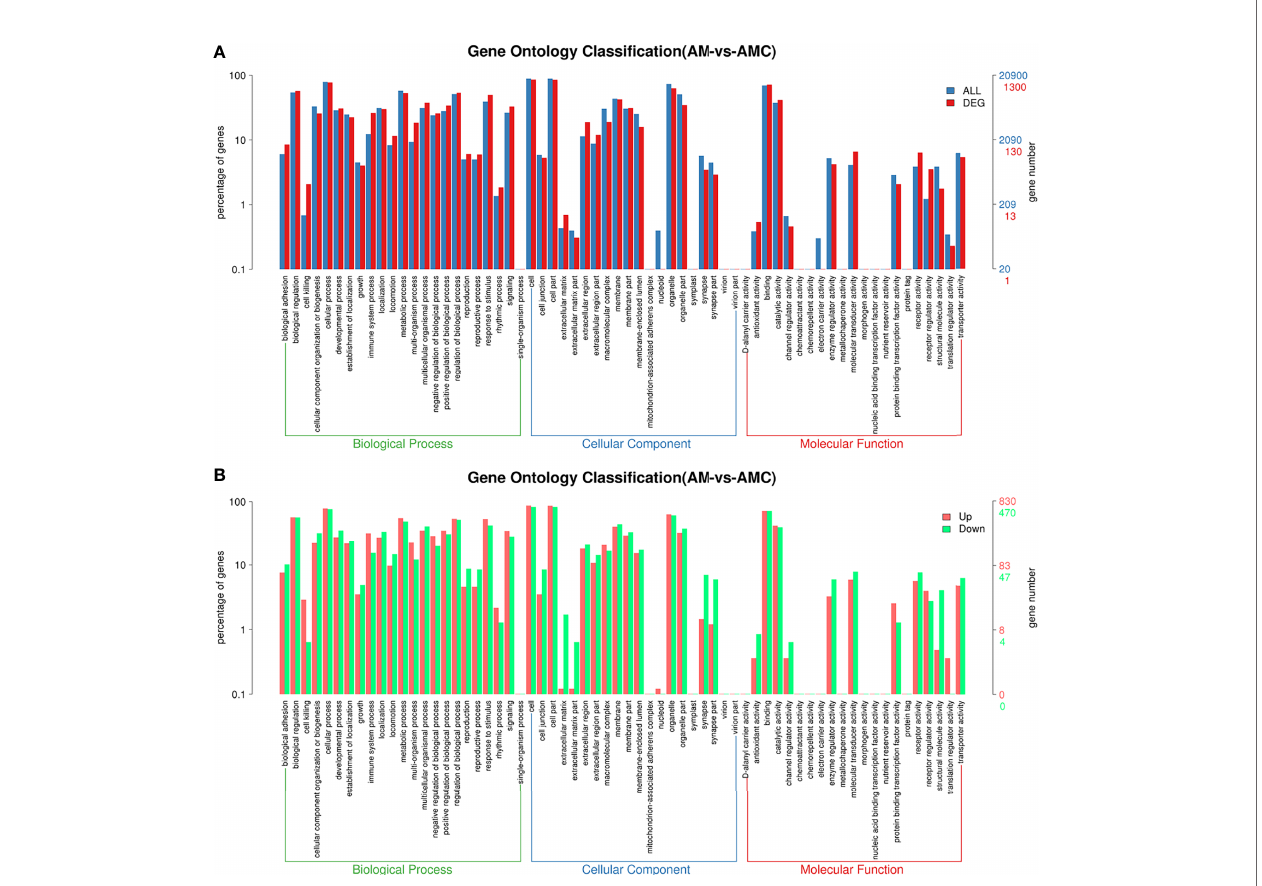
FIGURE 4 | Differential unigenes were analyzed by GO enrichment. (A) Comparison of distribution of differentially expressed unigene and all unigene at GO level2. Blue represents all unigene enriched GO level 2 items, red represents differential unigene enriched GO level 2 items, the horizontal axis represents the items name, and the vertical axis represents the number and percentage of unigene of corresponding items. (B) Comparison of upregulation and downregulation of unigene at GO level 2. Red indicates up regulation of go level 2 items enriched by DEGs, blue indicates down regulation of go level 2 items enriched by DEGs, the horizontal axis is the item name, and the vertical axis is the number and percentage of unigene of corresponding